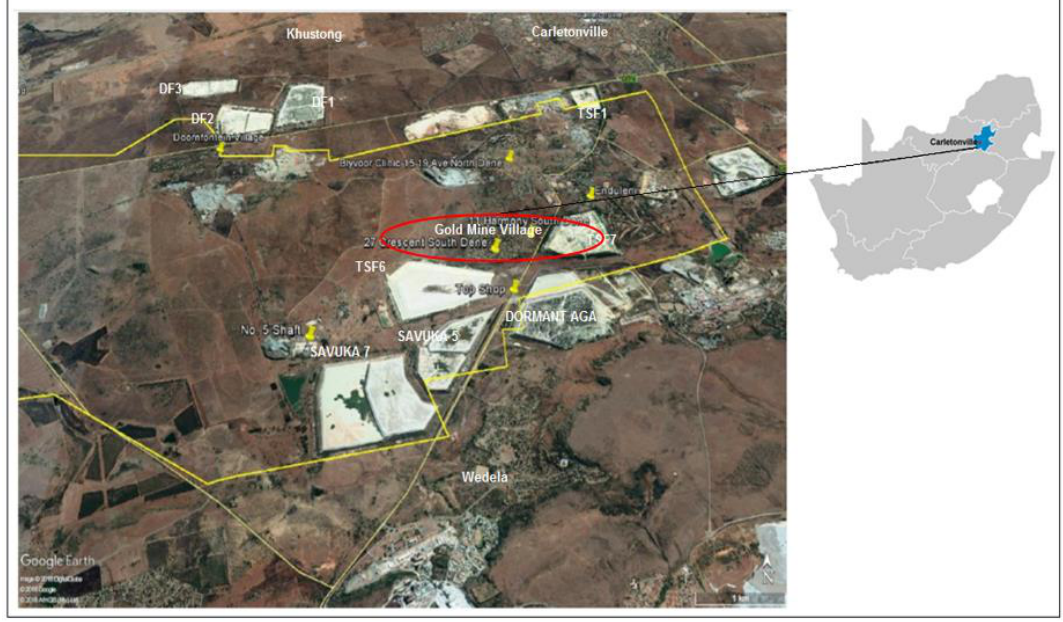
Figure 2. Study site with all TSFs in the vicinity of the gold mine village community.